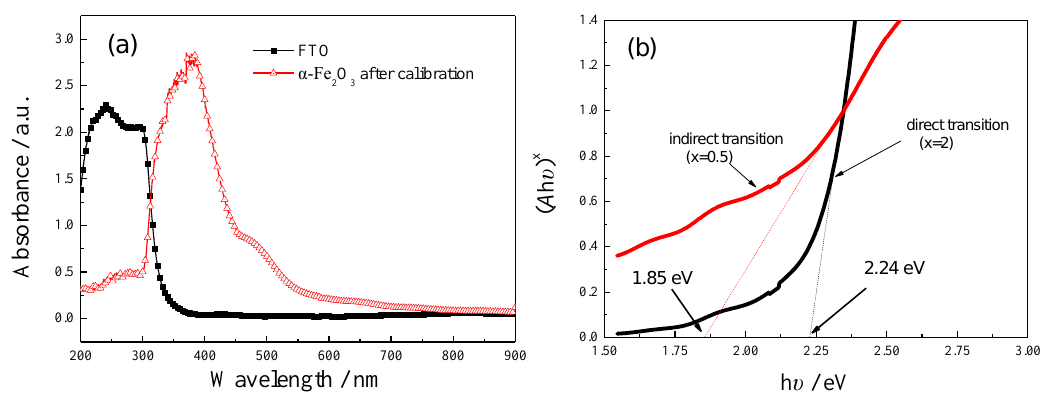
Figure 6. Optical absorption features of the α -Fe 2 O 3 nanorod arrays: ( a ) ultraviolet (UV)–visible absorption spectra; ( b ) Tauc plots.